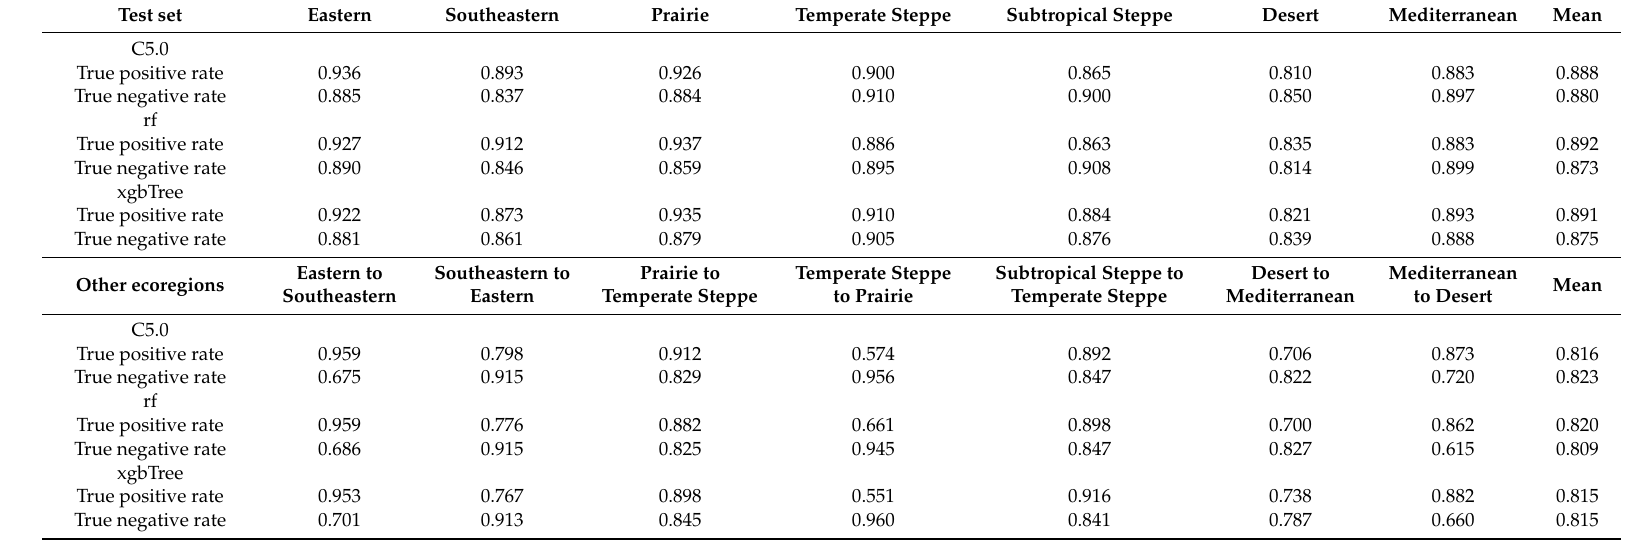
Table 5. True positive rate and true negative rate of predictions for three di ff erent classifiers (C5.0; rf = random forests, xgbTree = extreme gradient boosting with trees) for test set (25% of observations) and for adjacent ecoregions based on modeled training data of all fire occurrences during 1999–2017 for seven ecoregions.